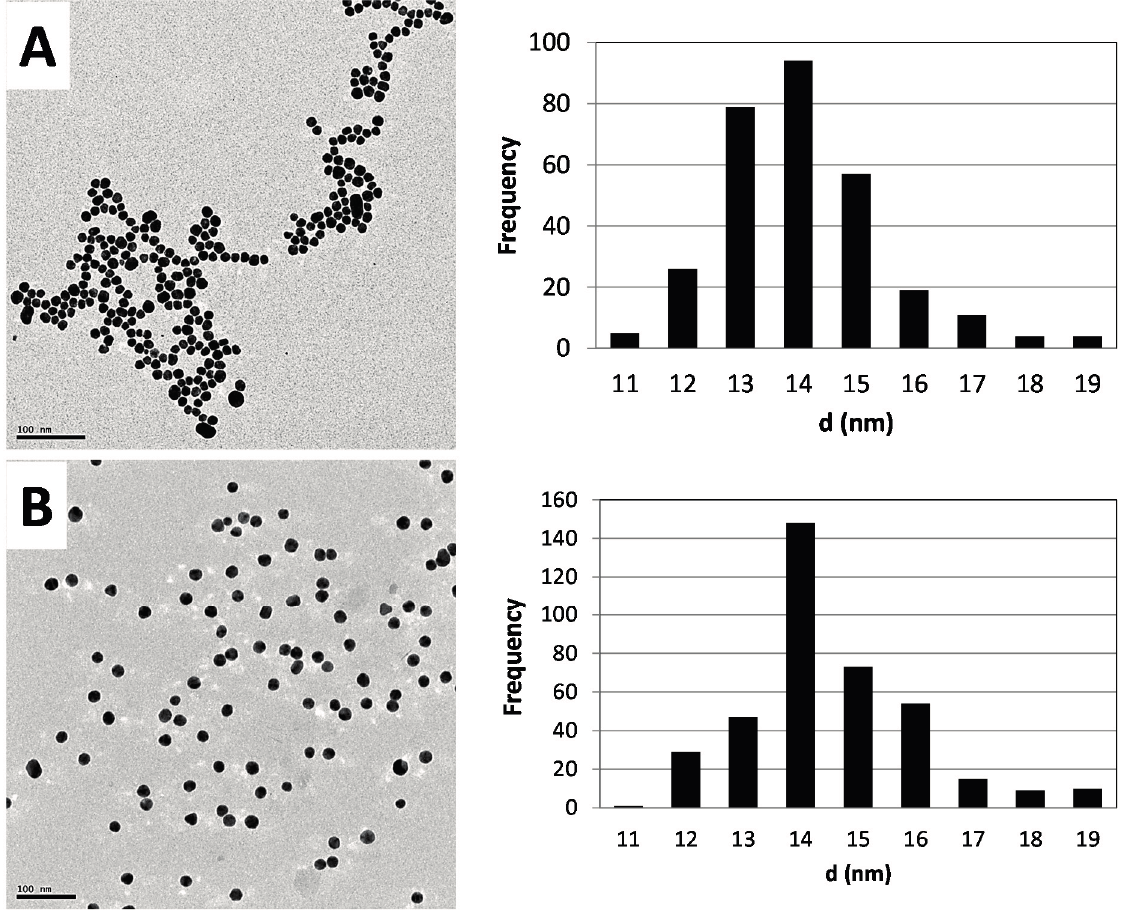
Figure 2. Morphology and size distribution profiles of the synthesized AuNPs fabricated from natural gold ( A ) and radioactive gold ( B ). On the left are TEM images, with the particle size distribution plots on the